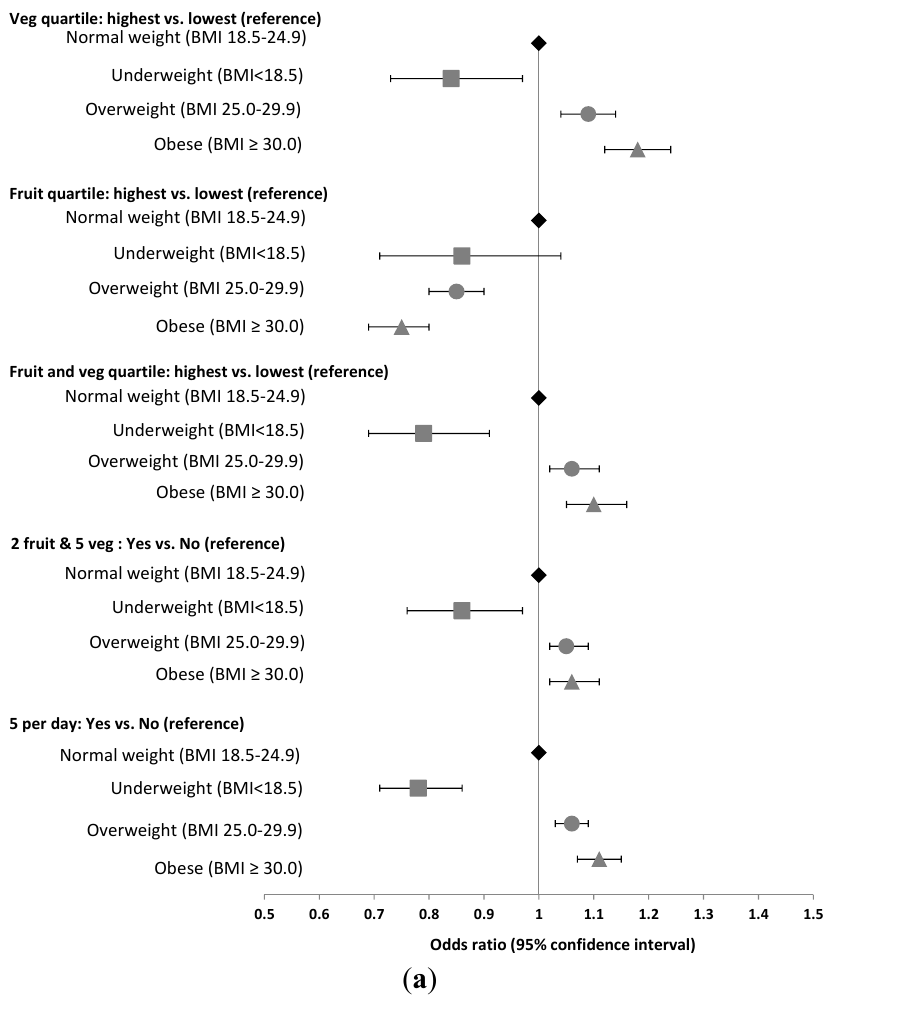
Figure 2. ( a ) Women: Adjusted * Odds Ratios and 95% Confidence Intervals for fruit and vegetable intake groupings, by BMI group; ( b ) Men: Adjusted * Odds Ratios and 95% Confidence Intervals for fruit and vegetable intake groupings, by BMI group. * Adjusted for age, education level, marital status, location of residence, income level, country of birth, physical activity, smoking, and alcohol